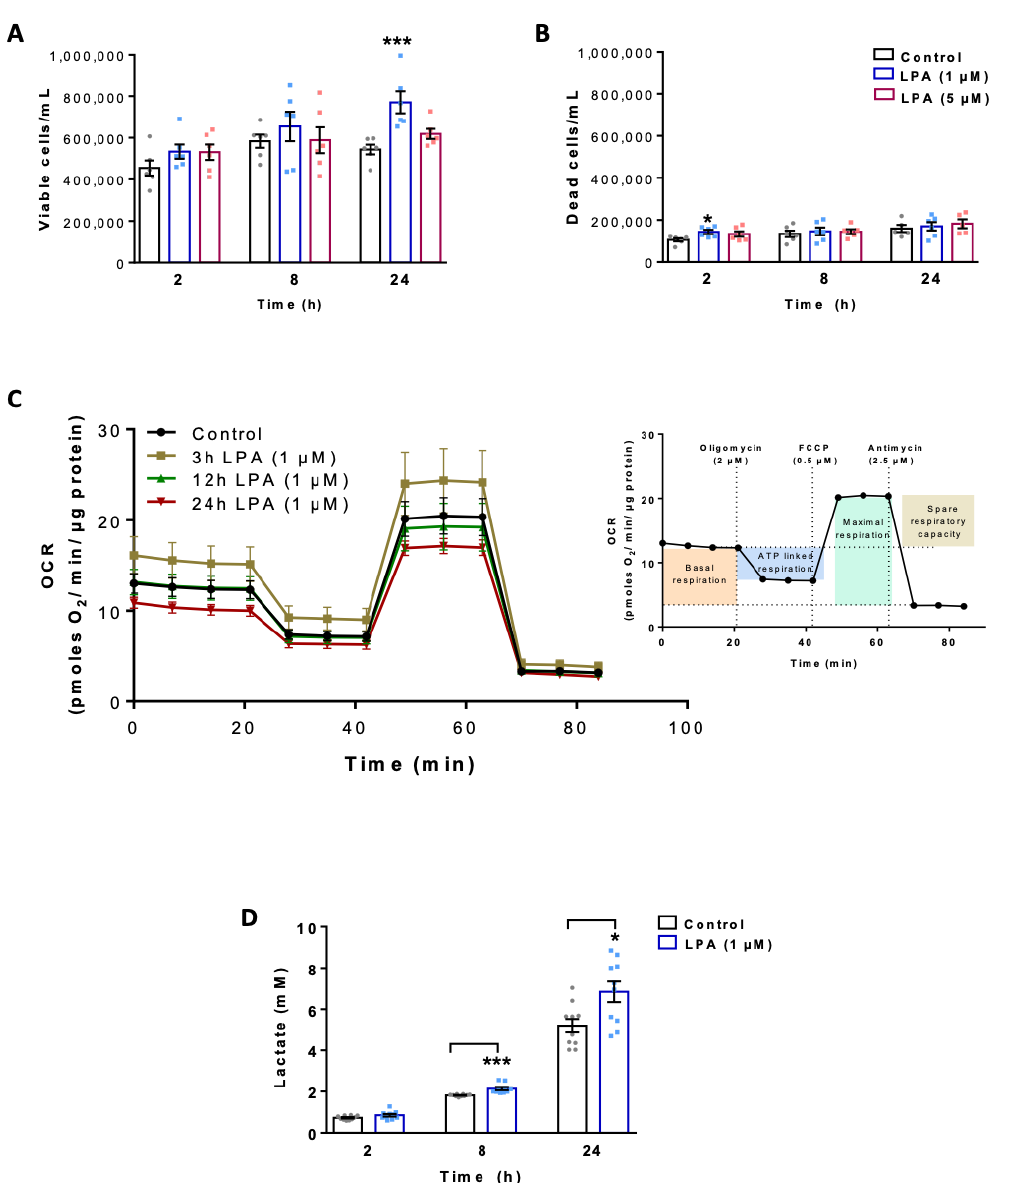
Figure 1. Effect of lysophosphatidic acid (LPA) on cell viability, mitochondrial respiration and lactate content of BV-2 microglia. The numbers of ( A ) viable and ( B ) dead cells were determined by Guava ViaCount analysis in the absence and presence of LPA. ( C ) Oxygen consumption rate (OCR) in the absence and presence of 1 µ M LPA for the indicated times was detected using the XF Cell Mito Stress Test. Cells were treated with 2 µ M oligomycin, 0.5 µ M FCCP, and 2.5 µ M antimycin A in XF assay medium to assess fundamental parameters of mitochondrial function (inset). ( D ) Lactate content in the supernatants of LPA (1 µ M) treated cells was measured by EnzyChrom™ Glycolysis Assay Kit and compared to their appropriate controls. Bar graph represents mean values ± SEM of 3 independent experiments; (* p < 0.05, *** p < 0.001 compared to control; one-way ANOVA with Bonferroni correction).